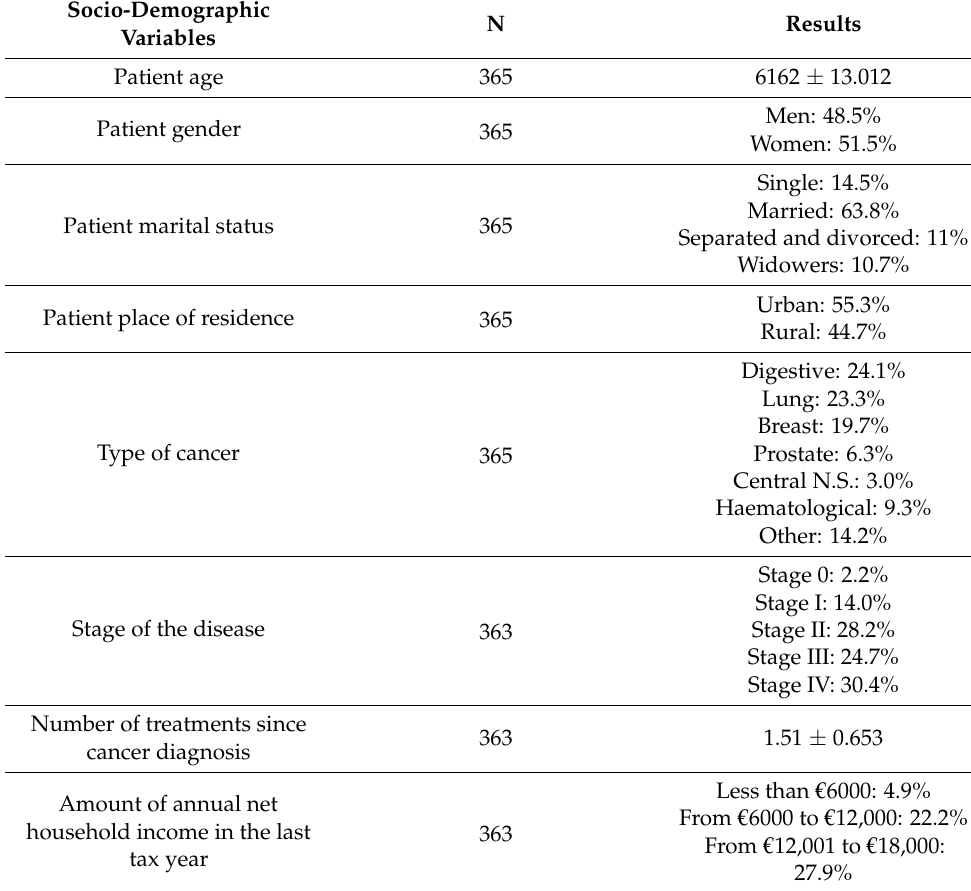
Table 1. Socio-demographic variables of the study